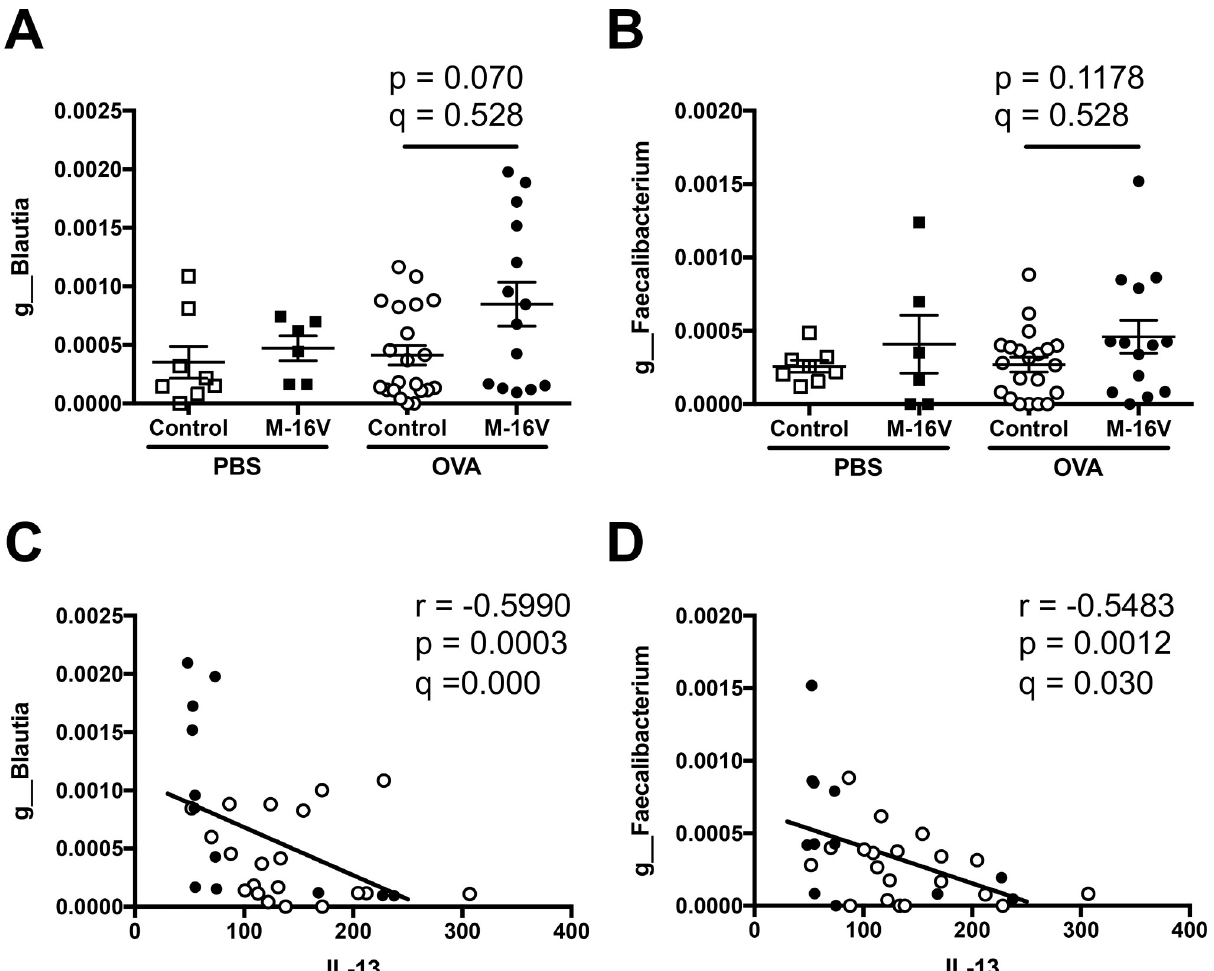
Fig 8. Relationship between IL-13 expression in the lungs and fecal microbiota composition of each sample. Relative abundance of ( A ) g_Blautia and ( B ) g_Faecalibacterium in samples from individual mice. The values are presented as the means ± SEM (n = 6–21). � P < 0.05 compared between control and B . breve M-16V diet OVA-allergic model mice. Spearman’s rank correlation between the relative abundance of ( C ) g_Blautia or ( D ) g_Faecalibacterium and IL-13 mRNA expression shown in Fig 3C. Q-value is an FDR adjusted p-value.